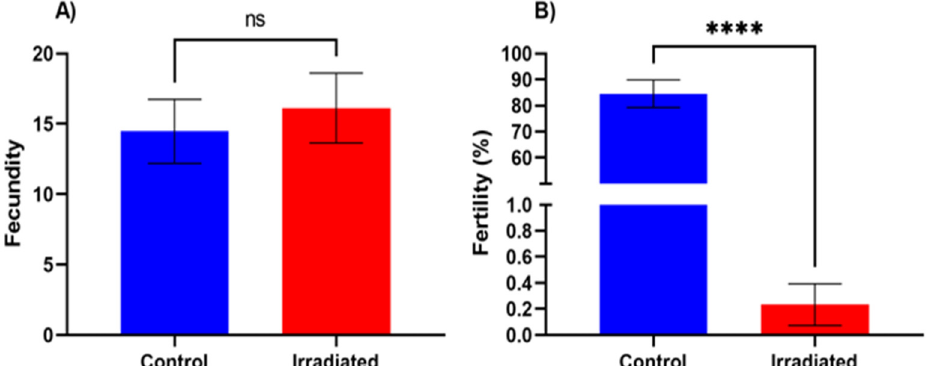
Figure 2. ( A ) Fecundity of the females (±SE) that mated with control (non-irradiated) and irradiated males. Fecundity is presented as the mean number of eggs laid per female in a 24 h period. ( B ) Fertility (%) (±SE) of females that mated with control (non-irradiated) and irradiated males. Fertility is presented as the percentage of eggs that hatched and developed to pupa stage. ns—no significant difference between treatments; asterisks represent a significant difference between treatments (**** = p < 0.001; Kruskal–Wallis test).